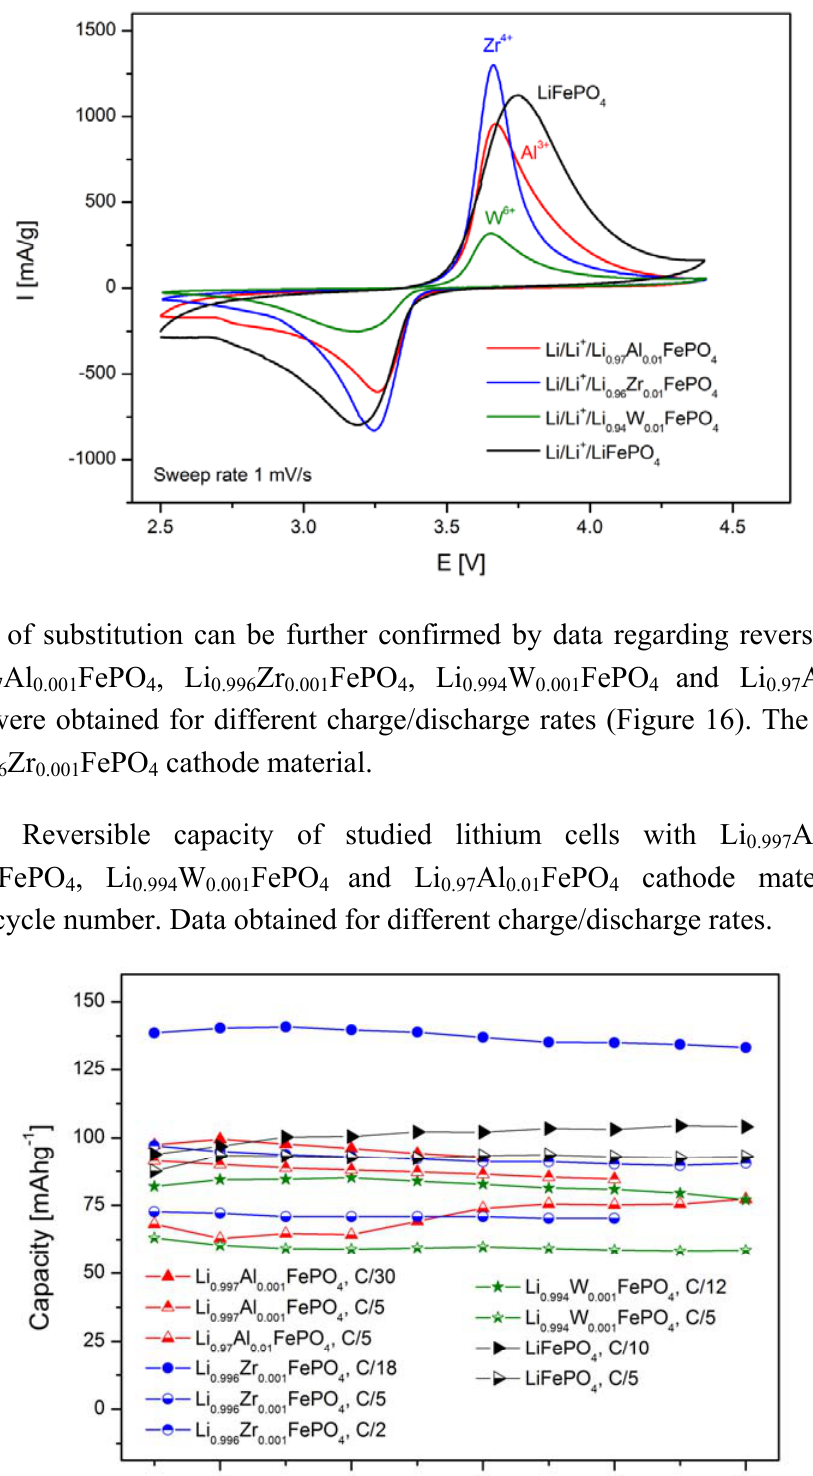
cathode materials [47]. 4